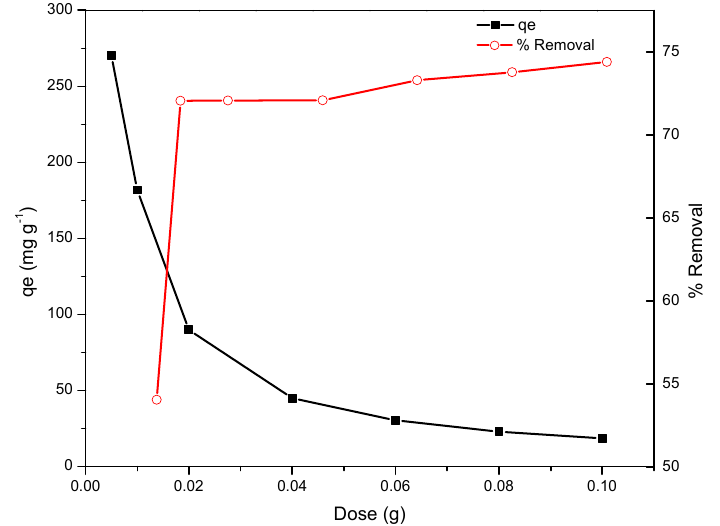
Figure 6. Effect of adsorbent dose on the removal and adsorption of MB dye by RF/TiO 2 gel.